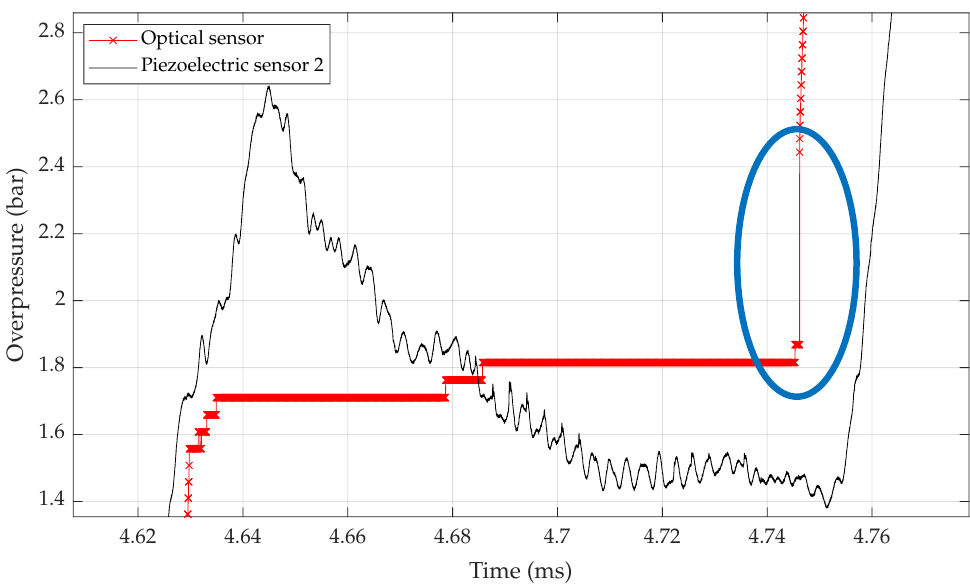
Figure 5. Discontinuity between overpressure steps P 2 and P 5 that is created by the use of a distinct acousto-optic models for the two-pressure step. The blue circled area is where points are